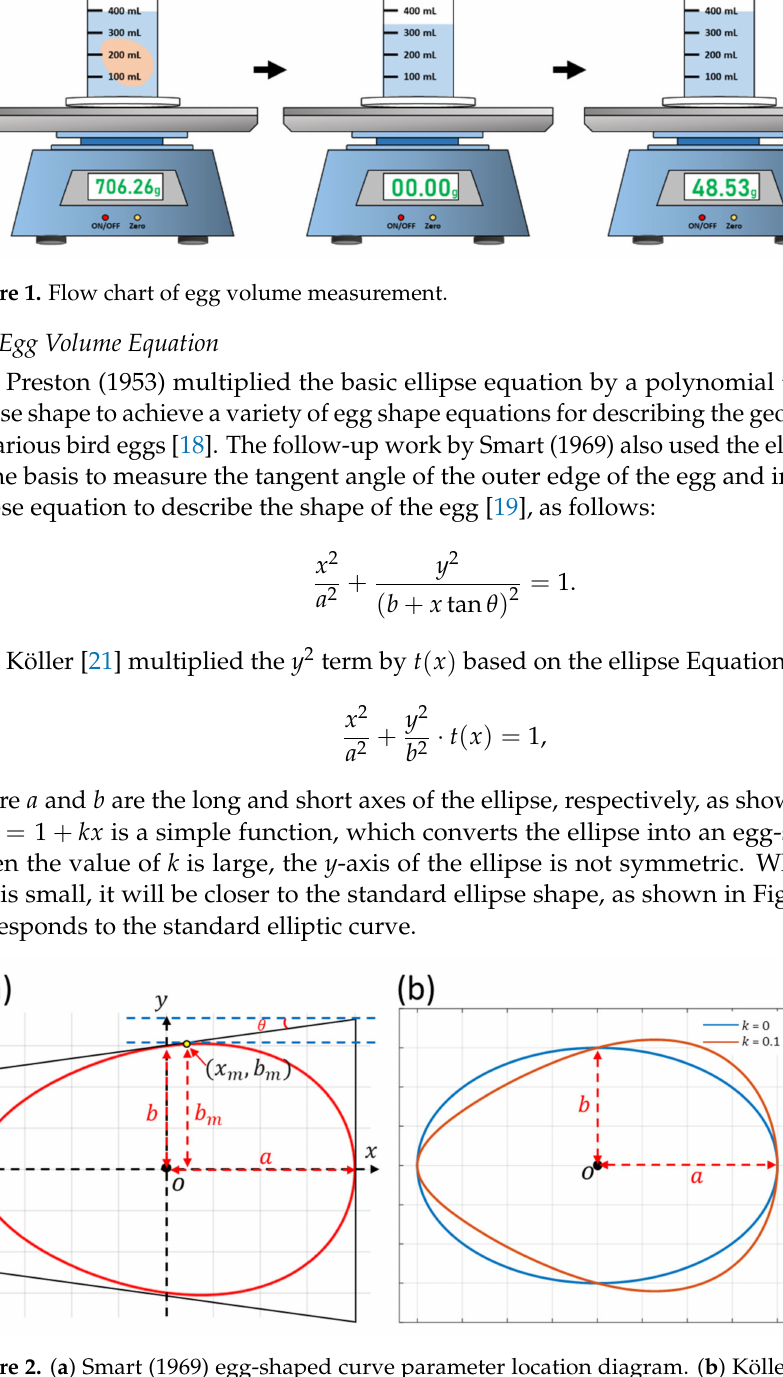
Figure 2. ( a ) Smart (1969) egg-shaped curve parameter location diagram. ( b ) Köller’s egg-shaped curve diagram of the change of the function k value in Equation